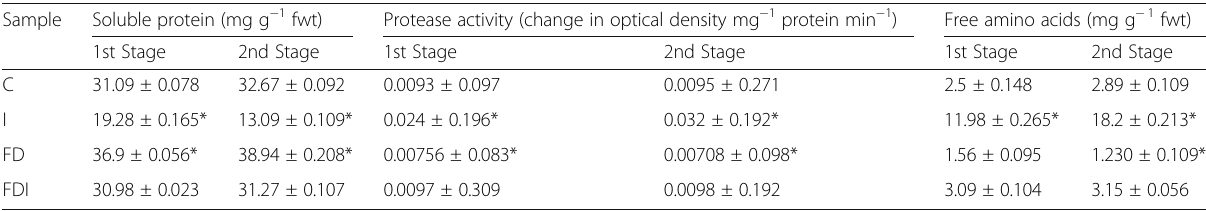
Table 1 Effect of defensin priming on protein hydrolysis (soluble protein, protease activity and free amino acids) in plants under Fusarium infection conditions